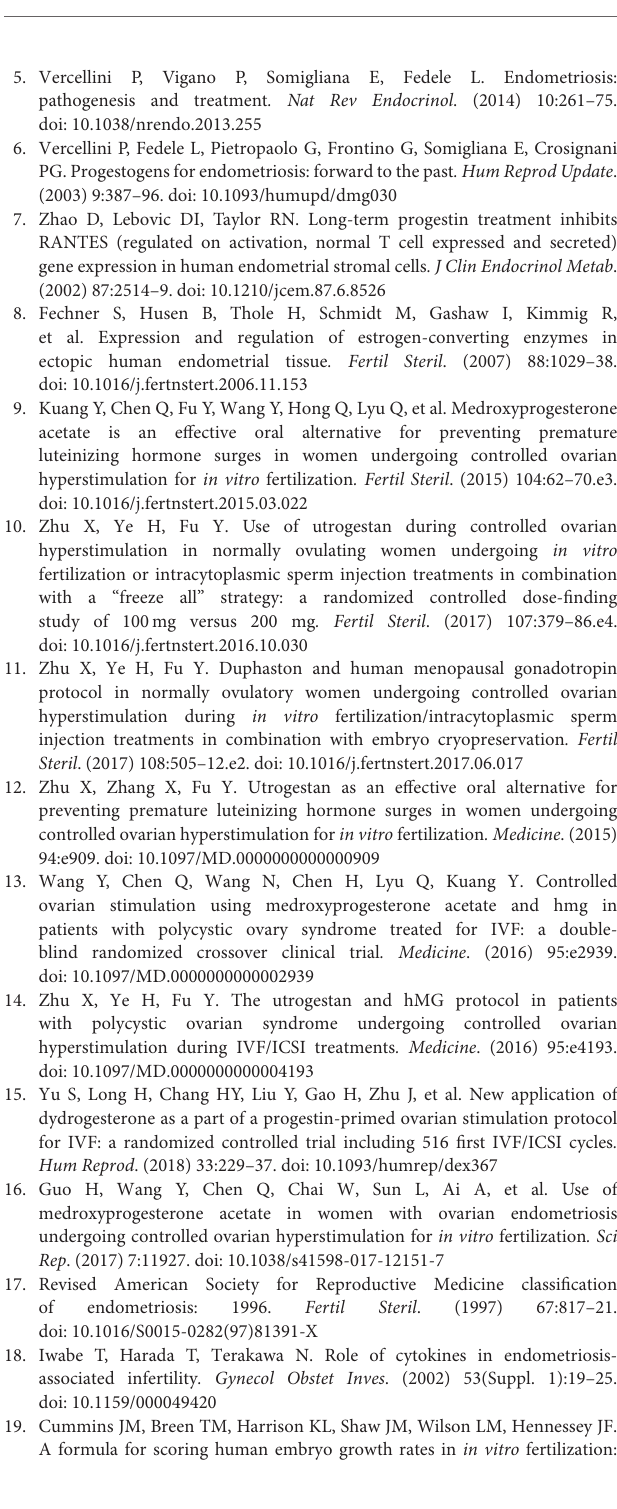
A formula for scoring human embryo growth rates in in vitro